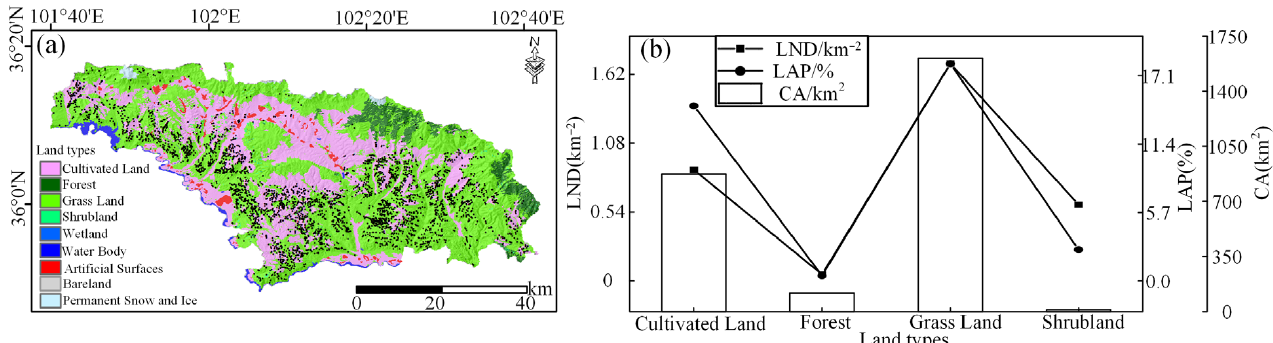
Figure 13. Relationship between land use type and landslide distribution. ( a ) Land use type distri- bution in the study area. ( b ) Statistics of landslide indicators in the land use type intervals.